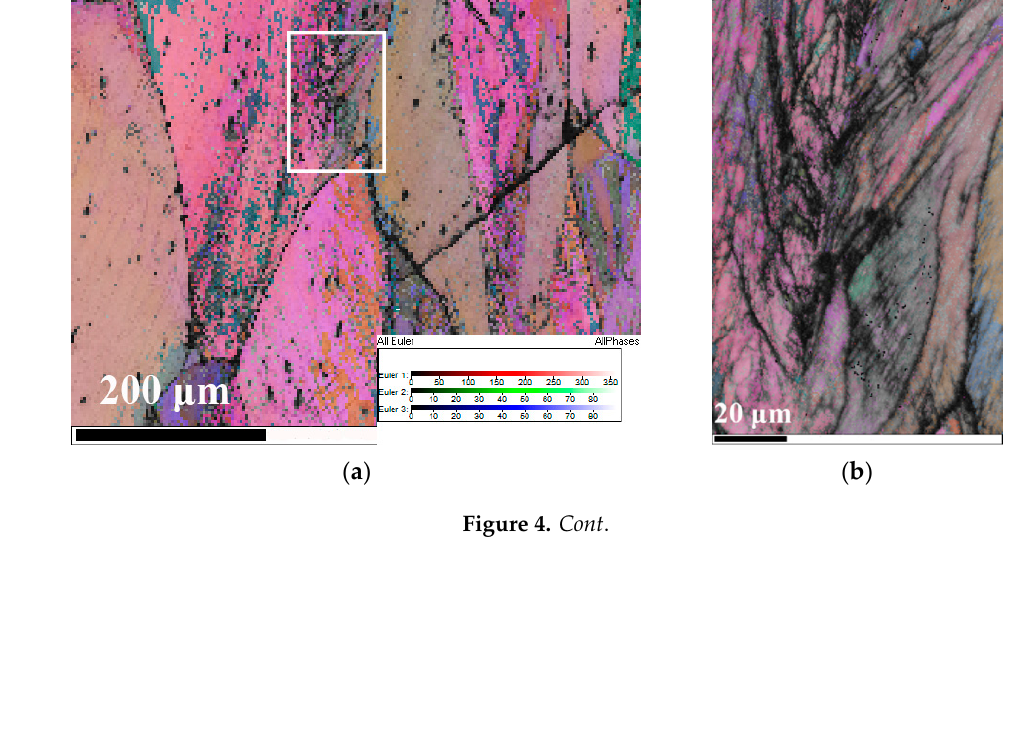
Figure 3. Optical micrographs of deformed samples under different strain rates: ( a ) 1250 s − 1 ; ( b ) 2000 s − 1 ; ( c ) 4800 s − 1 .